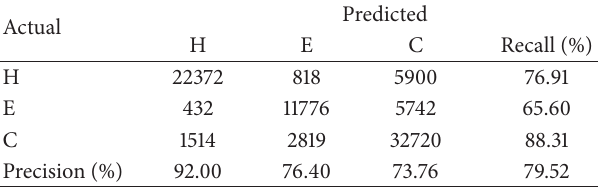
Table 8: Confusion matrix with